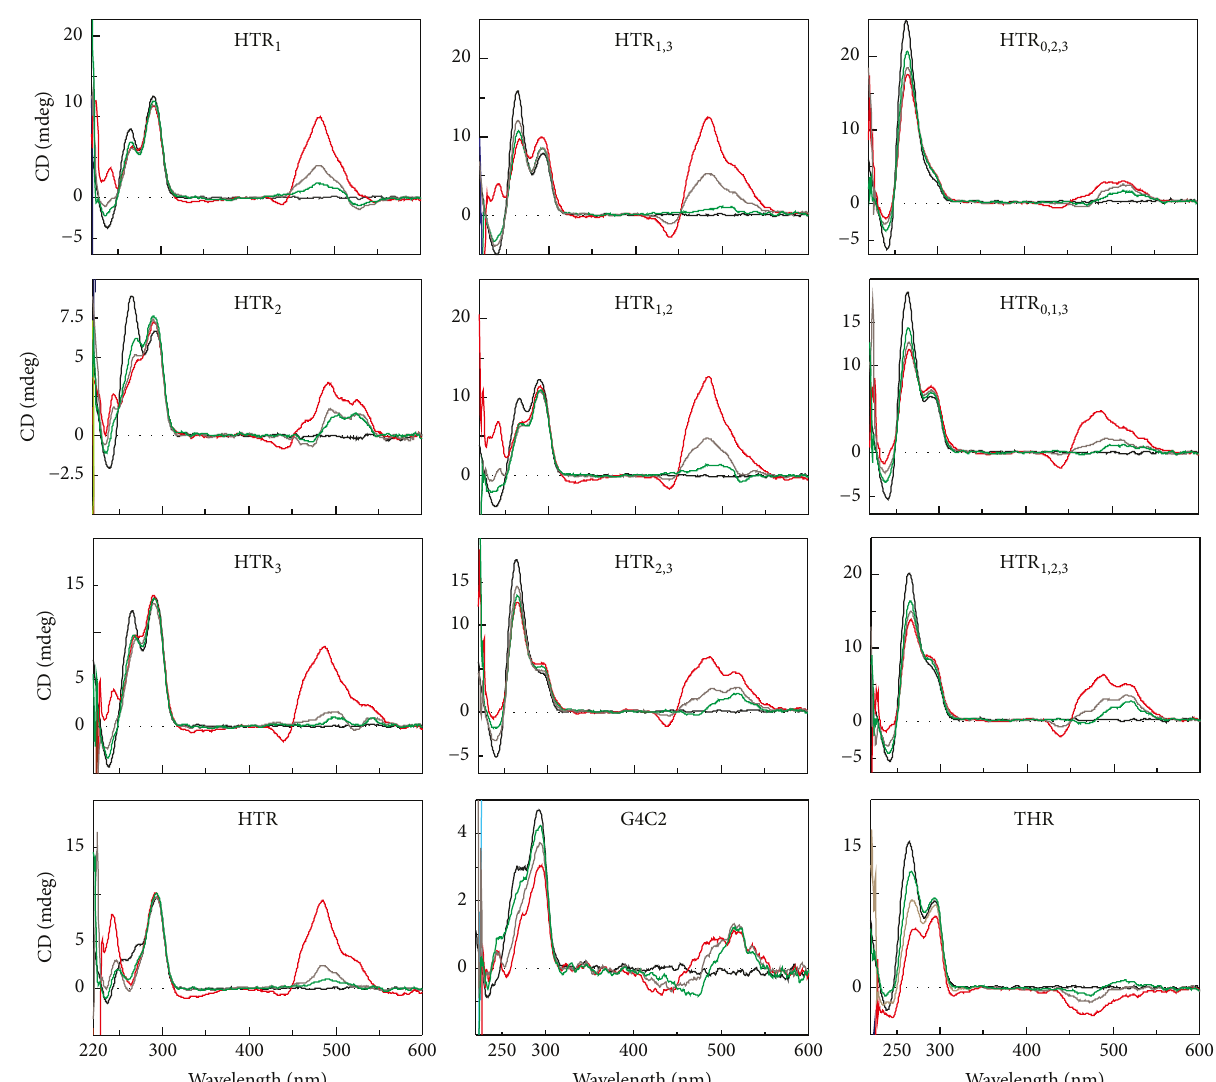
Figure 5: CD titration spectra of 27 𝜇 M DNA sample with TO. 0, 2.5, 5, and 7.5 molar equivalents of TO represented by black, green, brown, and red lines, respectively. Each sample was measured in a modified 25 mM mBR buffer containing 50 mM